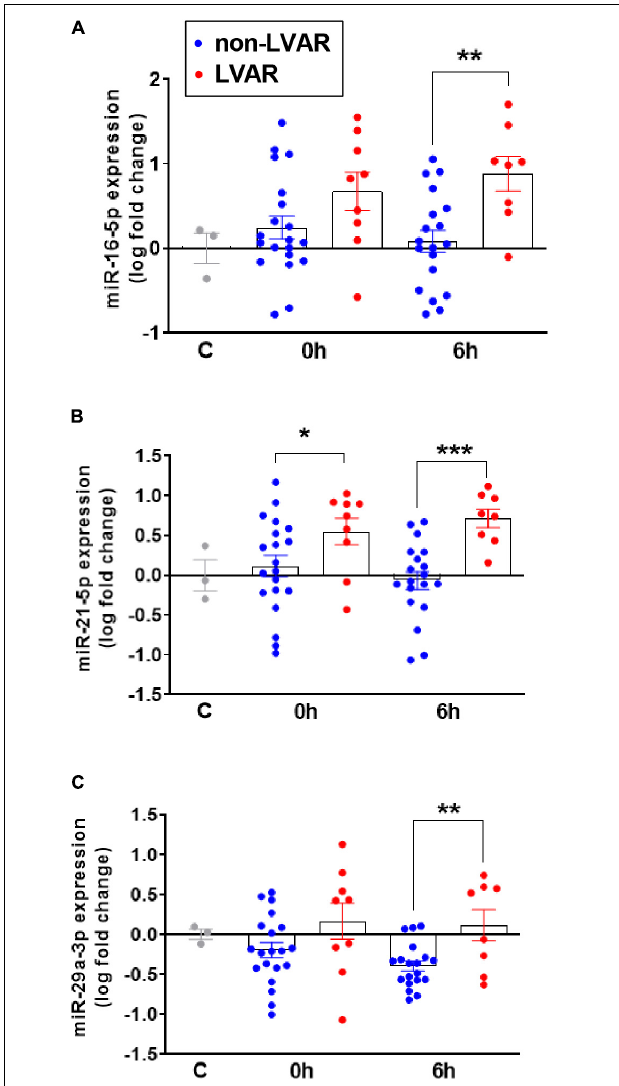
FIGURE 5 | Analysis of miR-16, miR-21 and miR-29a expression in PBMCs from non-LVAR and LVAR patients. (A–C) Bar graphs show the levels of expression of miR-16 (A) , miR-21 (B) and miR-29a (C) in controls and non-LVAR (blue dots, n = 20) and LVAR patients (red dots, n = 9), pre-PPCI (0 h) and post-PPCI (6 h). Values are presented as the means ± SEM. Ordinary one-way ANOVA with multiples comparisons using t -test without correction (Fisher’s LSD test) was performed. (*) indicates p < 0.05, (**) indicates p < 0.01 and (***) indicates p < 0.001. LVAR, left ventricle adverse remodeling; PBMCs, peripheral blood mononuclear cells; PPCI, primary percutaneous coronary intervention.